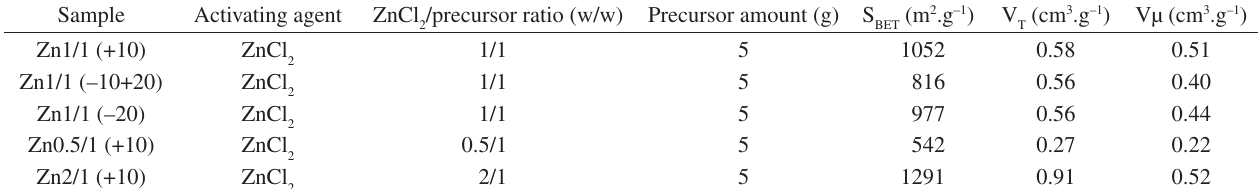
samples.Template size.Template Figure 4. Pore Size Distribution by DFT method for the samples sieved at (+10) mesh Figure 5. N adsorption-desorption isotherms for the physically activated 2 Table 2. Comparative data of the activated carbons using ZnCl Sample